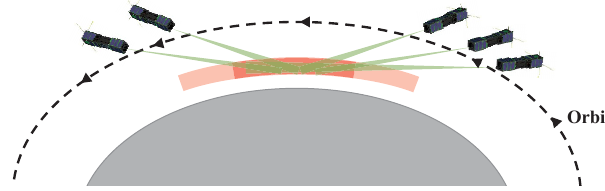
Figure 1. Viewing geometry of “target mode” observations of a re- gion in a mesospheric emission layer. This observation mode con- sists of forward limb, forward sub-limb and backward sub-limb measurements. The sub-limb measurements are taken with two dif- ferent viewing angles – 24.5 ◦ when the satellite is far from the tar- get region and 33 ◦ when it is closer. The viewing angle is the angle relative to the instantaneous horizon, with horizon defined as Earth surface for a given but temporally changing satellite